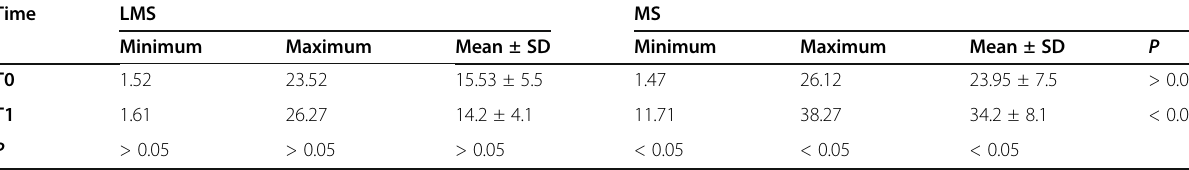
Table 3 Comparison of the level of interleukin 1 β (pg/mL) detected in the LMS and MS groups Time LMS